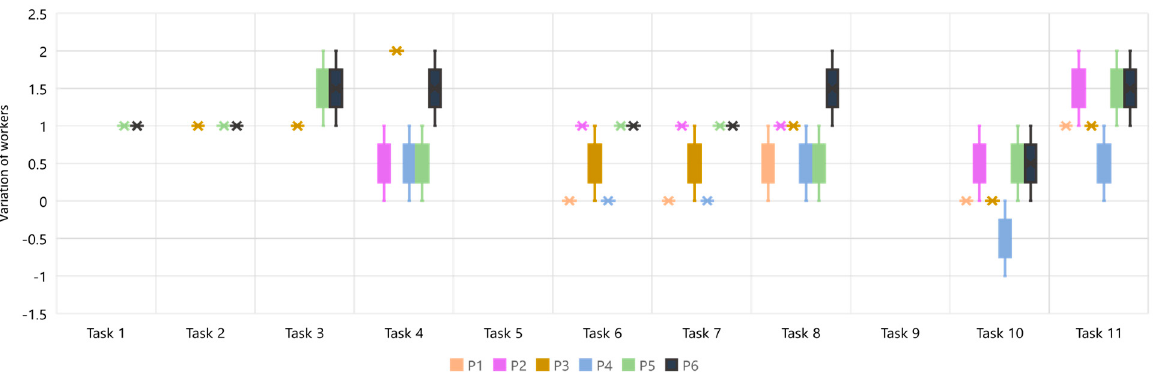
Figure 4. Deviation of the needed workers proposed by ChatGPT with respect to the baseline.